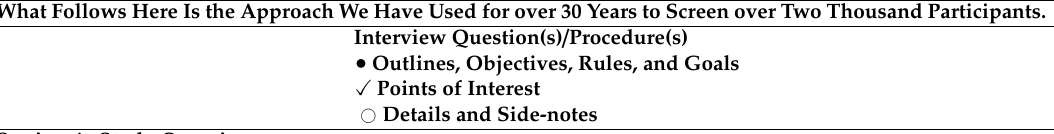
Table 4. The clinical interview: 12-point approach and levels of